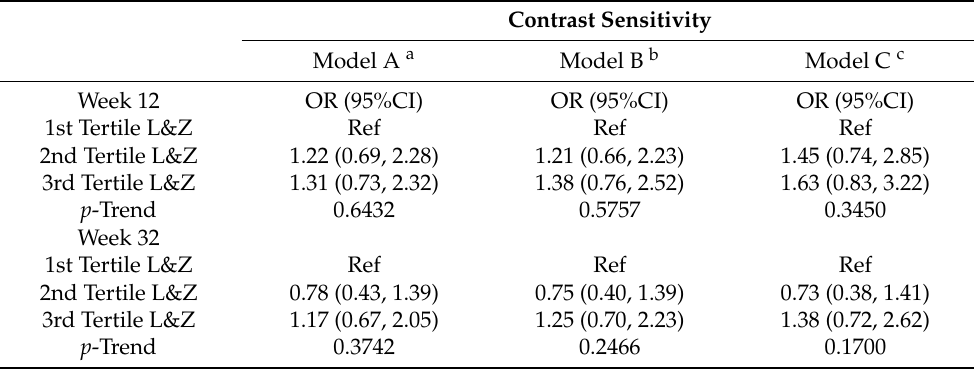
Table 2. Multiple adjusted analysis of the association between maternal L&Z intake during pregnancy and low contrast sensitivity and visual acuity based on the lowest 20th centile cut off in the Sabadell cohort of the Spanish Childhood and Environment (INMA)